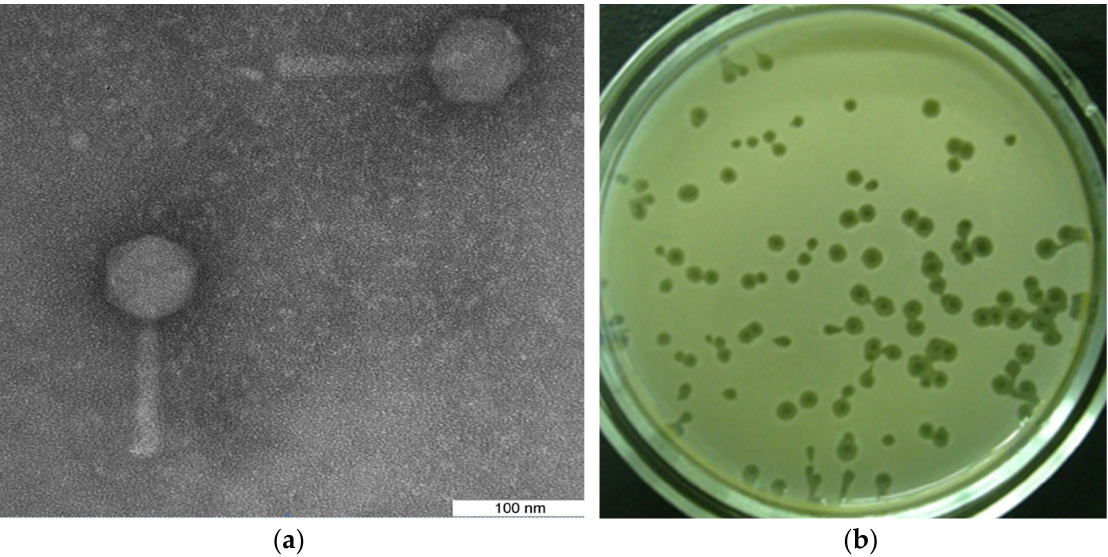
Figure 3. An electron micrograph of bacteriophage ph 57 particles. Uranyl acetate staining method ( a ) and morphology of negative colonies of bacteriophage ph 57 on a matte background of P. aeruginosa CEMTK 670 culture ( b ).